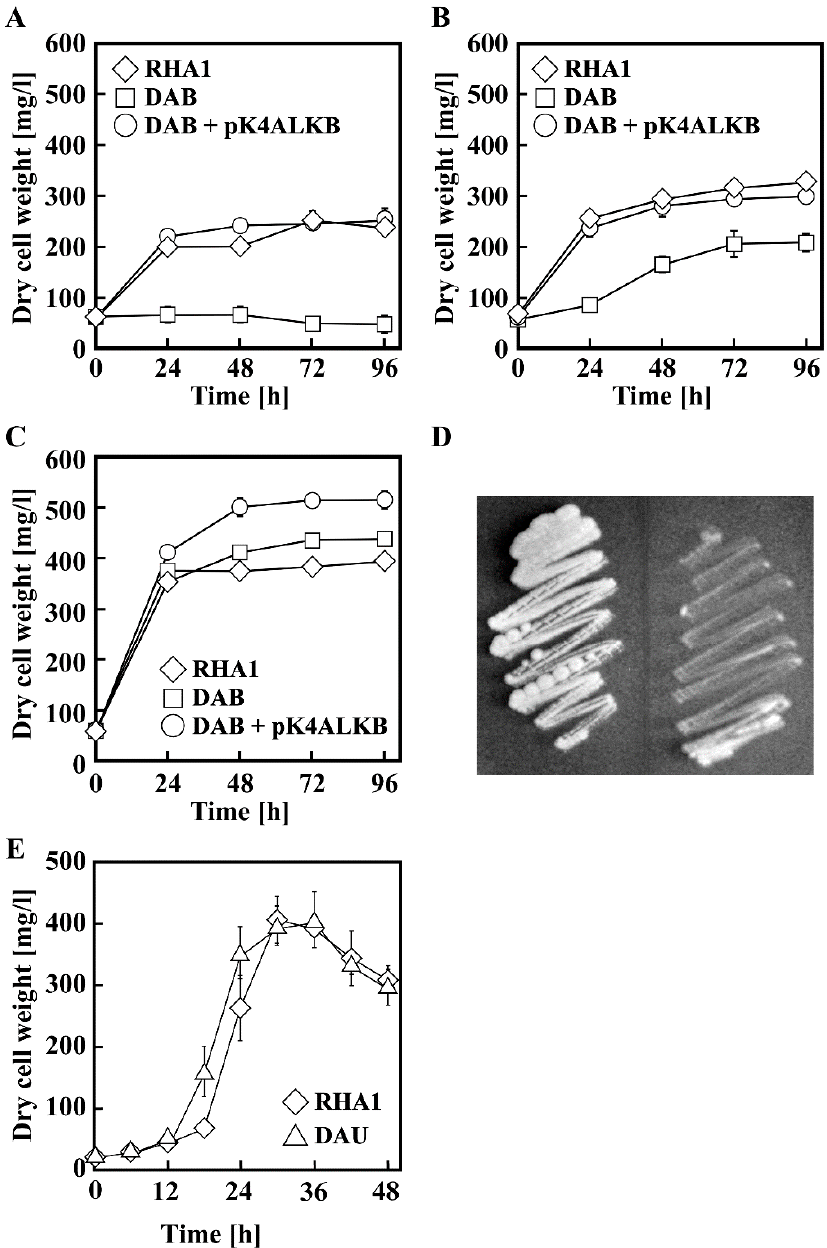
Figure 4. Growth of RHA1 and its mutant derivatives on n -undecane ( A ), n -dodecane ( B ), n -hexadecane ( C ), and n -decane ( D ). ( A – C ) RHA1 (diamonds), DAB (squares), DAB harboring pK4ALKB (circles) were grown in W medium containing 10 mM of each n -alkanes. Each value is the average ± standard deviation of three independent experiments. ( D ) Growth of RHA1 (left) and DAB (right) on n -decane after 5 days of incubation. ( E ) Growth of RHA1 (diamonds) and DAU (triangle) on 20 mM n -undecane.